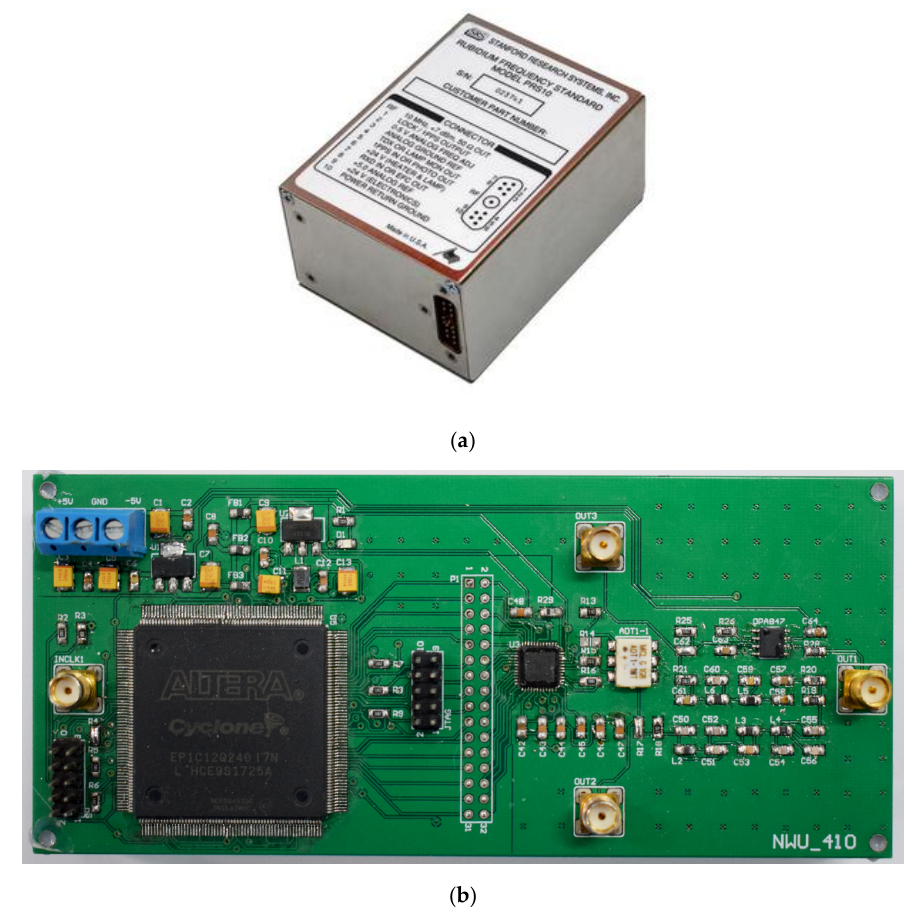
Figure 6. Modules of DDS frequency synthesizer based on FPGA. ( a ) Standard frequency source rubidium atomic clock PRS10; ( b ) FPGA implementation platform of DDS.